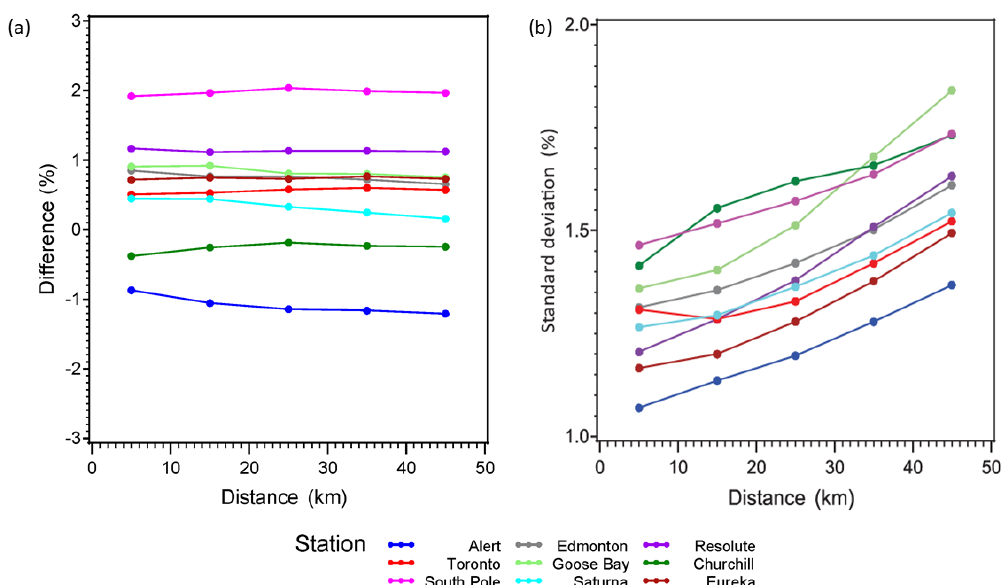
Figure 1. The percentage difference (a) and the standard deviation (b) of the TROPOMI OFFL TOC compared to GB measurements versus the co-location search radius (in km) for nine Brewer stations of the Canadian Brewer Network (see Table S4 in the Supplement for details on these stations).